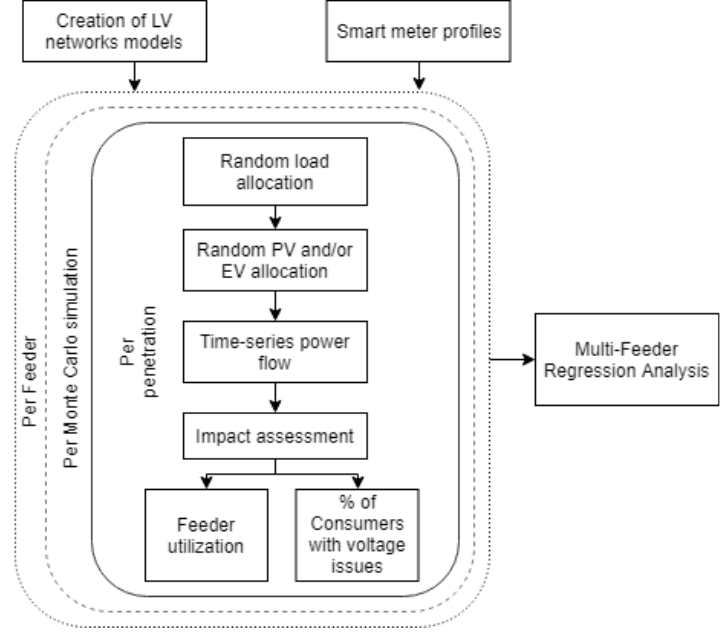
Figure 1. Methodology Base Framework.